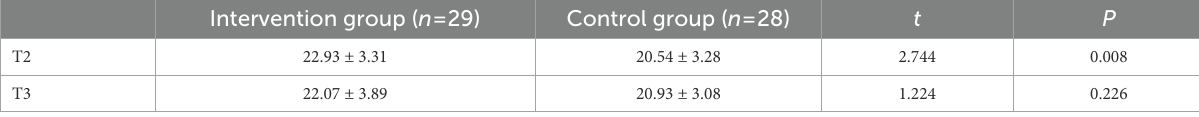
TABLE 6 Comparison of positive coping score among the intervention group and control group after